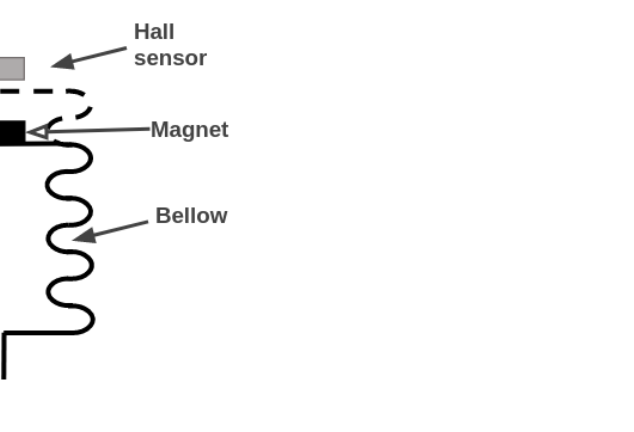
Figure 23. Working principle of the pressure sensor. The Hall-effect sensor is fixed, while the magnet moves according to the applied pressure.